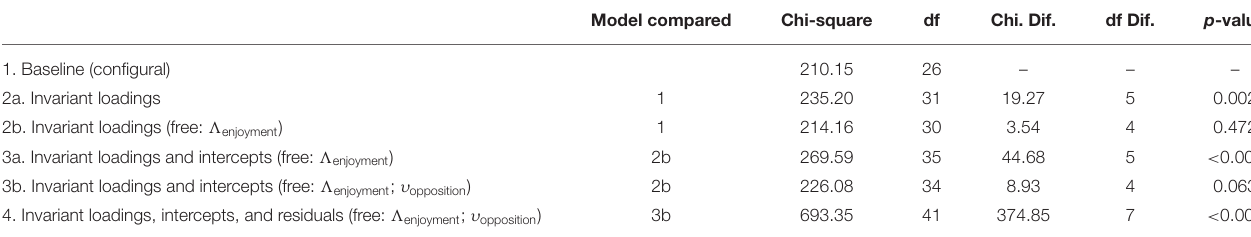
TABLE 5 | Goodness-of-fit indices and Chi-square difference tests for models testing measurement invariance with respect to country. Model compared